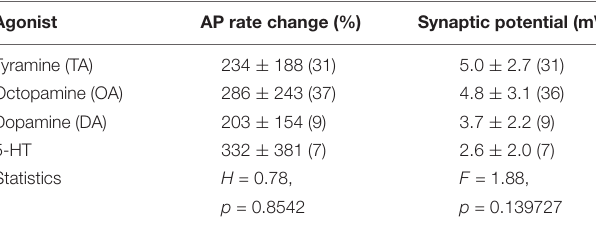
TABLE 2 | Agonists effects on AP rate and membrane